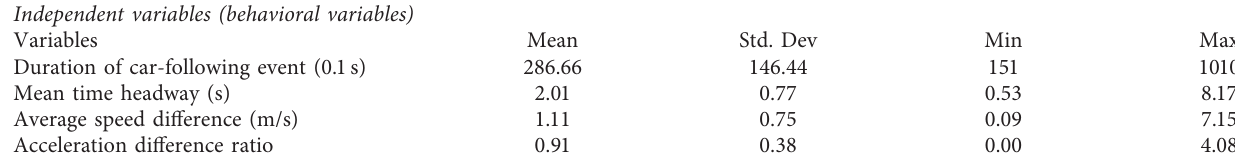
Table 3: Summary of variables descriptive